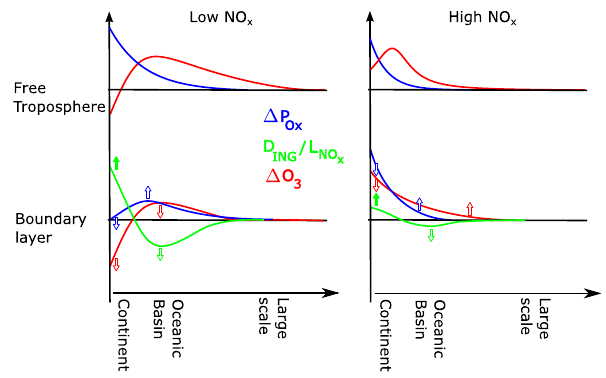
Fig. 9. Schematic representation of the spatial modulation of the O x budget by the isoprene photochemical cascade. Isoprene chem- istry alters ozone production (blue) locally by altering the abun- dance of NO x ; reduction in NO x due to formation of isoprene ni- trates ( D ING / L NO , continent) leads to reductions in O x . Down- x wind of continents, however, the release of NO x by ING promotes ozone formation. The resulting net impact of isoprene photochem- istry on regional ozone, thus, depends on the NO x conditions near isoprene source regions. Under high–NO x , an increase in the con- tinental removal of NO x (green filled arrow, right panel) by iso- prene results in a net increase of ozone downwind of continents (1 O 3 > 0, red empty arrows). This reflects the enhanced transport of nitrogen reservoirs from regions of low OPE (continents) to re- gions of high OPE (oceans). Conversely, under low–NO x , a similar increase in NO x removal (green filled arrow, left panel) can result in a decrease of ozone downwind of continents, as the contrast in OPE is not sufficient to overcome the decrease in continental ozone advected as well as the increased loss of NO x during its transport (e.g., deposition of ING). The removal of NO x by isoprene nitrate chemistry also increases the amount of BVOCs injected in the free troposphere, promoting the production of ozone. This indirect ef- fect of isoprene chemistry on ozone is of opposite sign to the direct effect and impacts ozone away from isoprene